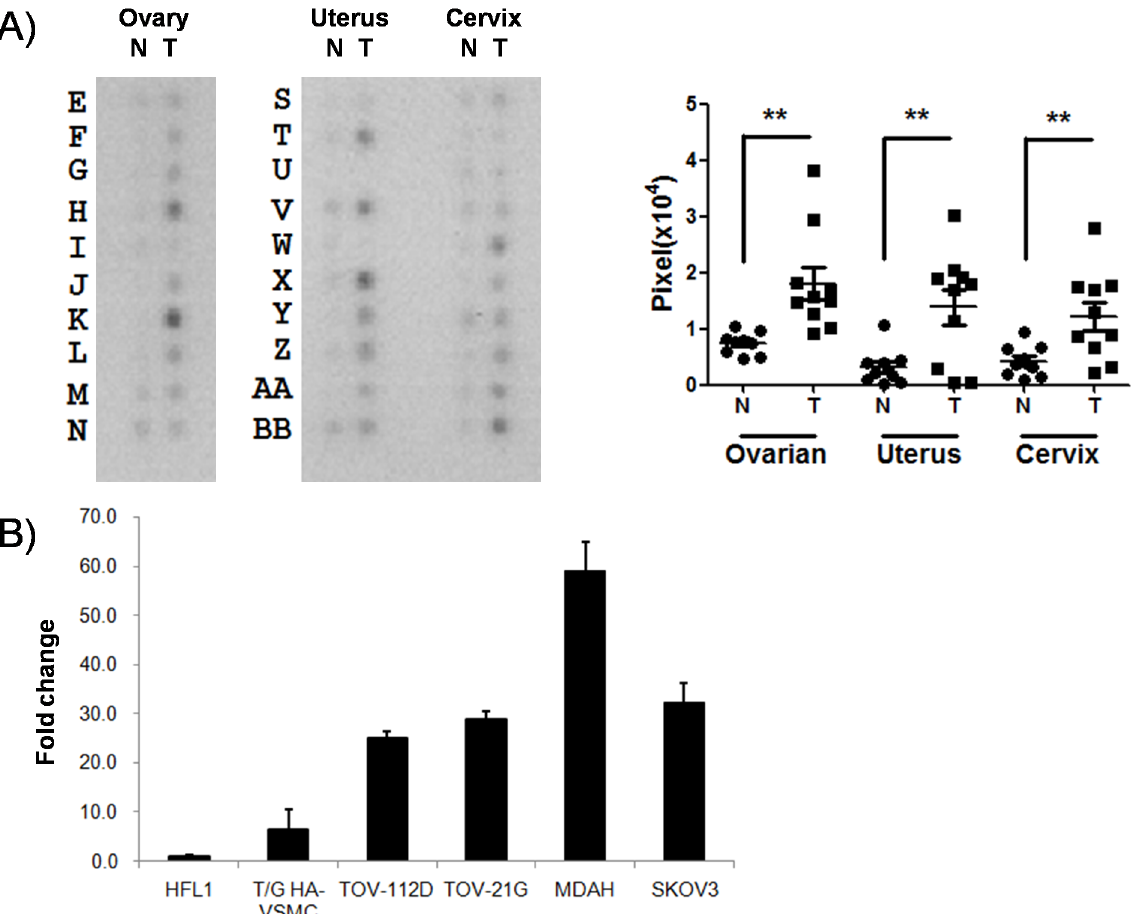
Fig 1. The mRNA profiles of BAIAP2L1 on tissues and cell lines. (A) The Cancer Profiling Array II (BD Clontech) of cDNA derived from normal tissues (N) and tumor tissues (T) of ovary, uterus, and cervix. Quantitation of the mRNA of tumor and normal tissues of different sites are shown at the right panel. BAIAP2L1 expression in tumors was significantly higher than that in normal tissues ( ** P < 0.01). (B) BAIAP2L1 RNA expression in ovarian cancer cell lines was higher than normal cell lines. Ovarian cancer lines included serous type (SKOV3), endometrioid type (TOV112D, MDAH2774), and clear cell type (TOV21G). HFL1 is human normal lung fibroblast cell, and T/G HA-VSMC is human normal aorta smooth muscle cells. Abbreviations : T, tumor; N,